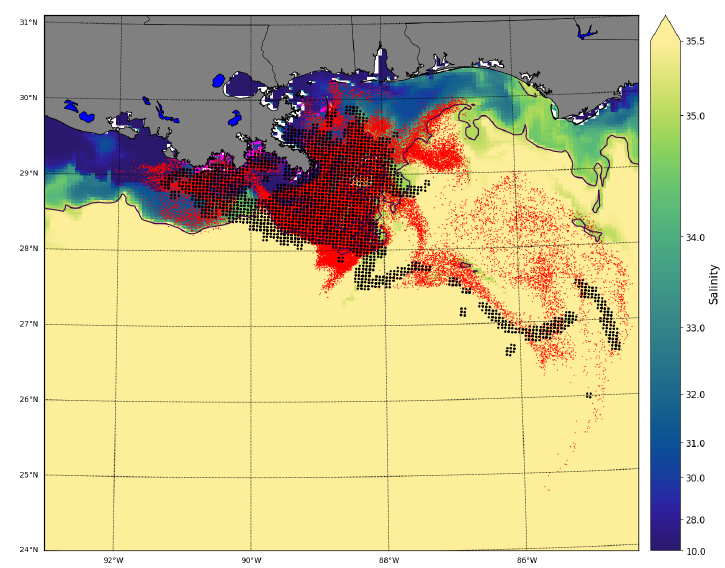
Figure 10. End condition of the Reference simulation 20–27 May 2010 same simulation as in Figure 9a, showing active elements at surface as red dots and the corresponding observed surface oil patch (NOAA shape file) as black dots. Modeled stranded oil is shown in magenta. The color scale shows sea surface salinity in the forcing data. The black contour is the 35 PSU isoline.